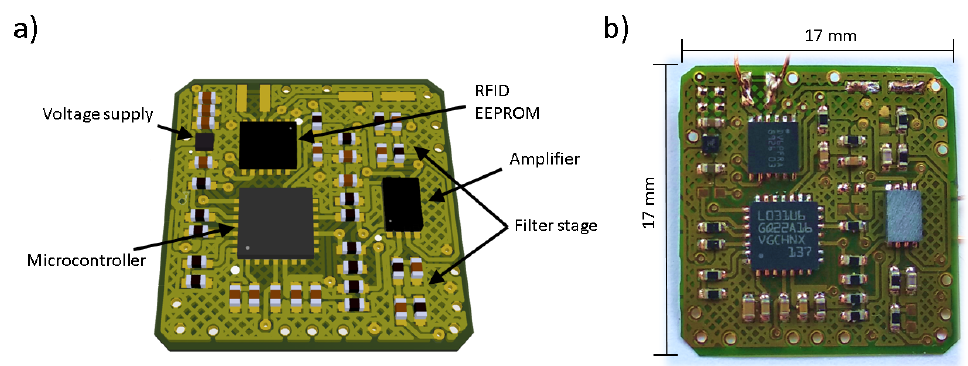
Figure 1. Sensor node for embedded GUW sensor connection. ( a ) sensor node from CAD with main part description; ( b ) photograph: manufactured and assembled